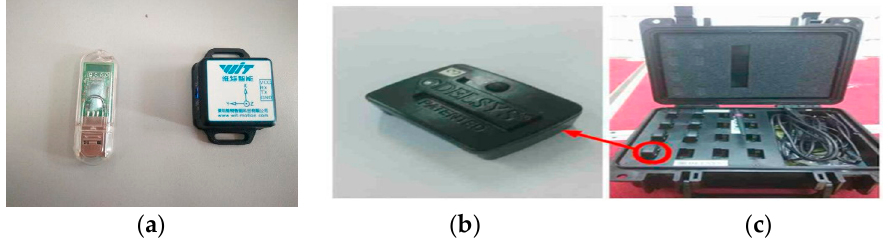
Figure 2. Sensors for motion data collecting. ( a ) MPU9250 angle sensor; ( b ) Delsys accelerator; ( c ) Wireless acquisition system.